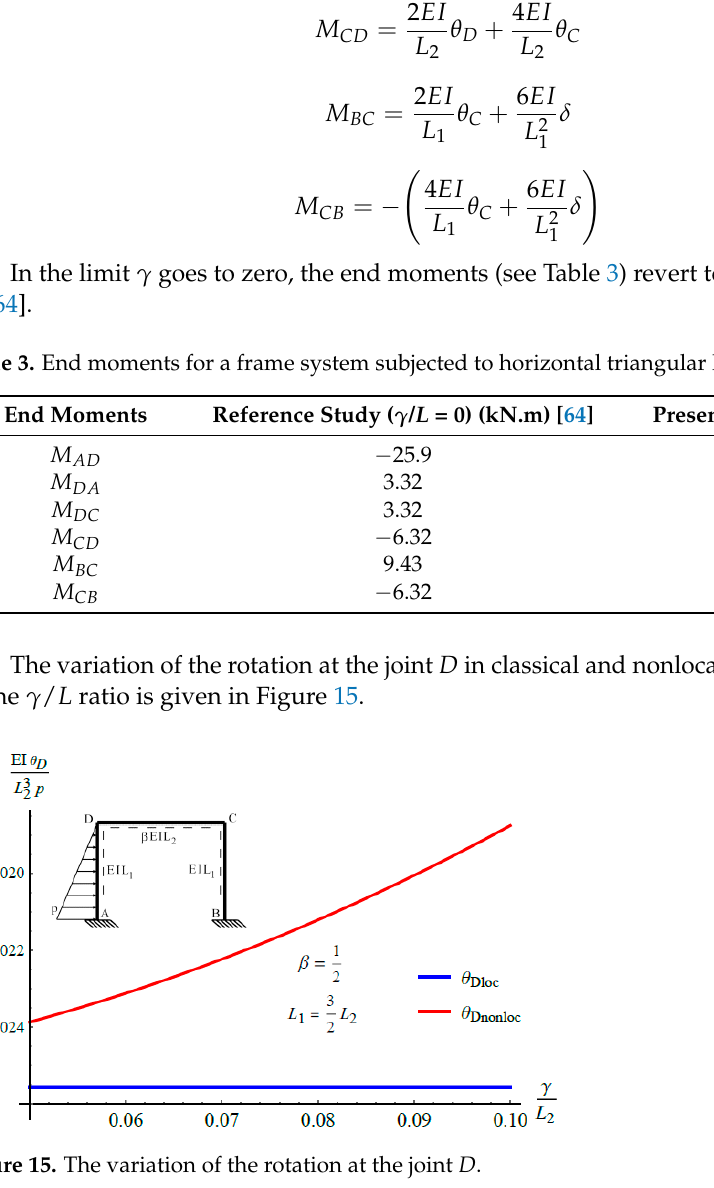
Figure 15. The variation of the rotation at the joint D